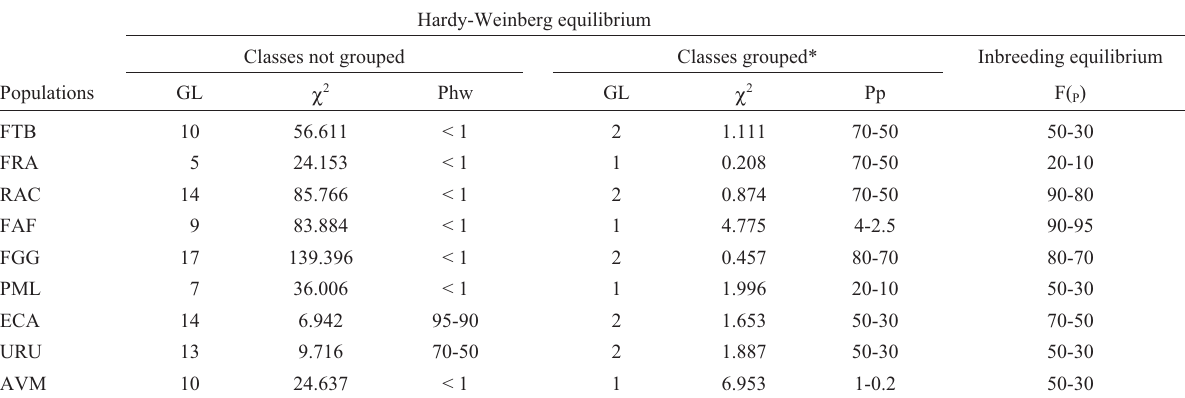
Table IV - Chi-square ( χ 2 ) for the Hardy-Weinberg equilibrium deviation based on observed and expected frequencies, grouped or not, and inbreeding equilibrium, of nine natural Araucaria angustifolia populations. Hardy-Weinberg equilibrium Classes not grouped Classes grouped* Inbreeding equilibrium